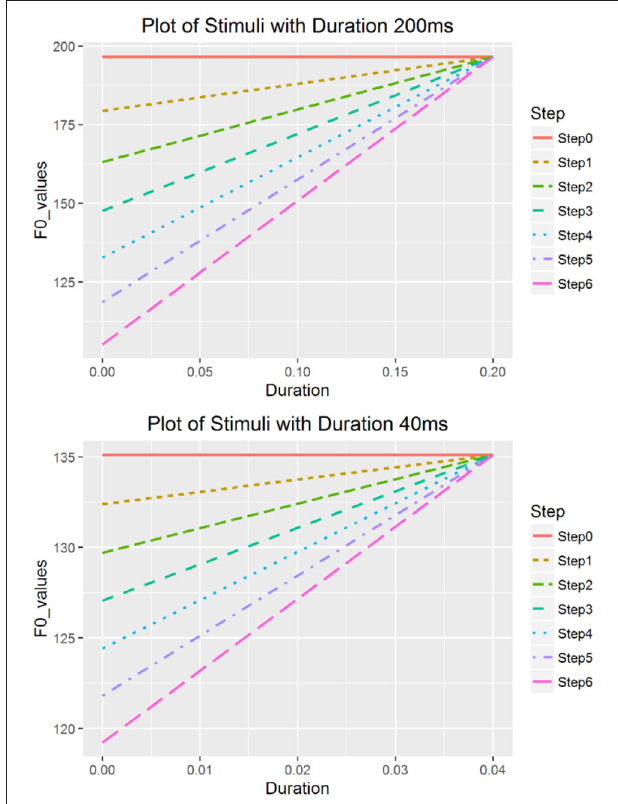
FIGURE 1 | Rising continua with duration of 200ms (top) and 40ms (bottom).